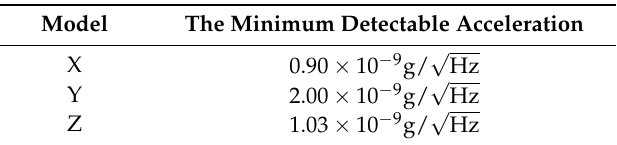
Table 3. The minimum detectable acceleration of the tri-component geophone.